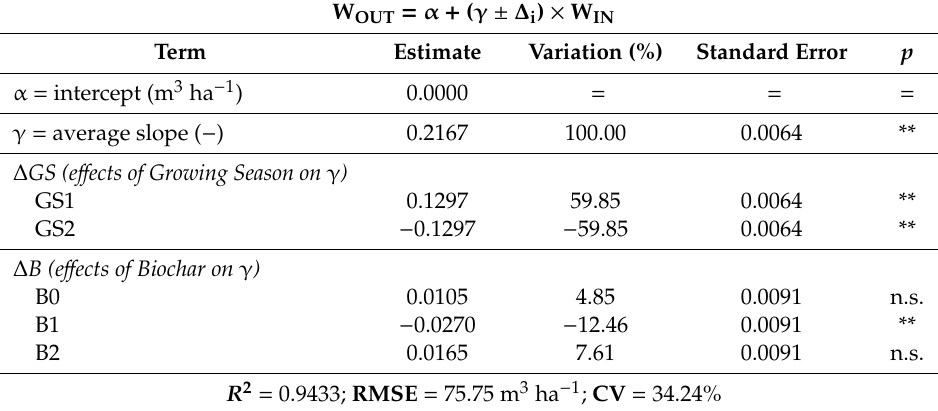
Table 2. Statistical results of the analysis of covariance (ANCOVA) drainage model (see the first table line for the equation). The coe ffi cient estimates, their percentage variation with respect to the average slope, standard errors and their corresponding probabilities are shown. Summary of fit is also reported in the lower part of the